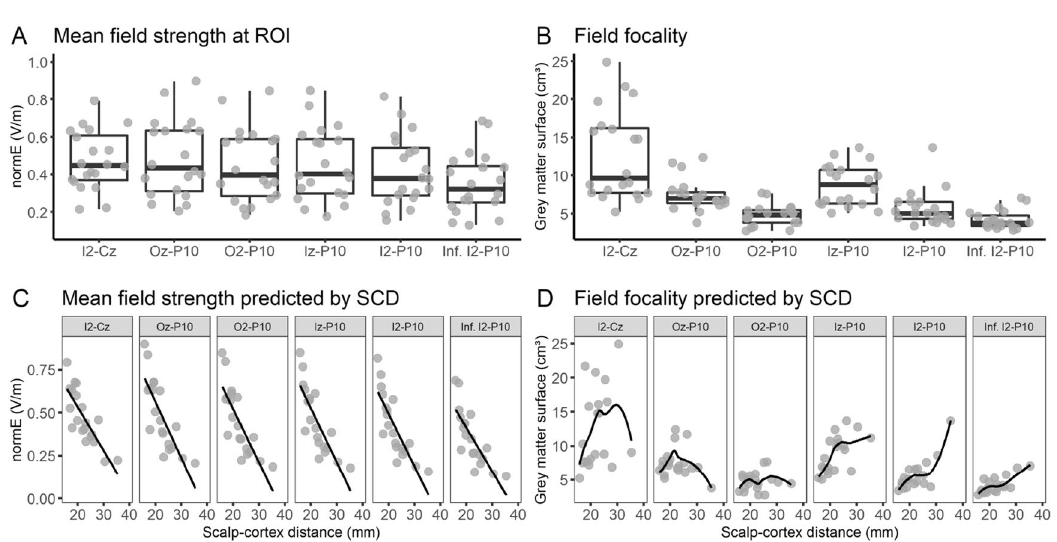
Figure 6. Overview of descriptive values of ( A ) mean field strength and ( B ) field focality for the six alternative montages tested in Experiment 2, as well as their association with individual scalp–cortex distance (SCD; C , D ). Individual points correspond to individual head Field focality. As illustrated in Fig. 5, the alternative montages affected field focality to different extents. Extrac- erebellar current spread was lowest with the I2–P10 and inferior I2–P10 montages. There were no significant differences in field focality between Oz–P10 and Iz–P10, O2–P10 and I2–P10, and O2–P10 and inferior I2–P10 ( p s > 0.999). All other montages significantly differed from each other ( p s < 0.047), with O2–P10 and inferior I2– P10 exhibiting the best focality (Fig. 6B). Compared to the conventional montages, only the O2–P10 ( p s < 0.005),